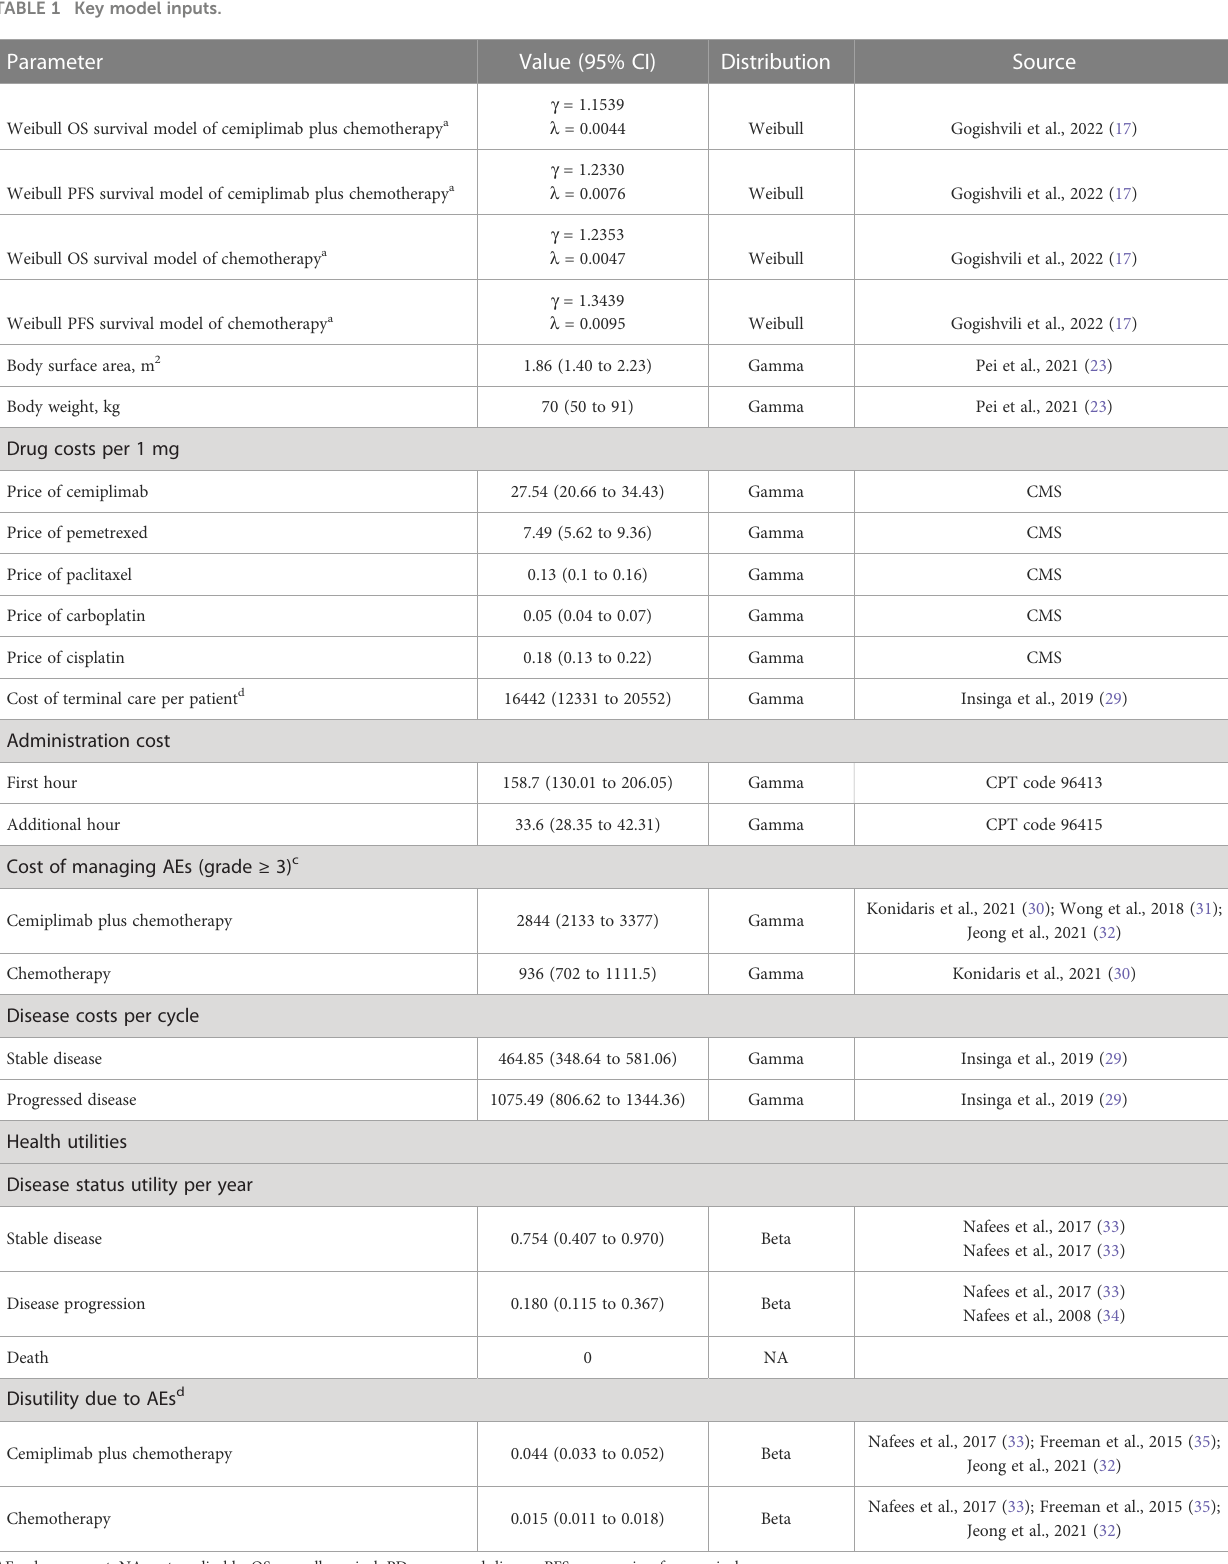
TABLE 1 Key model